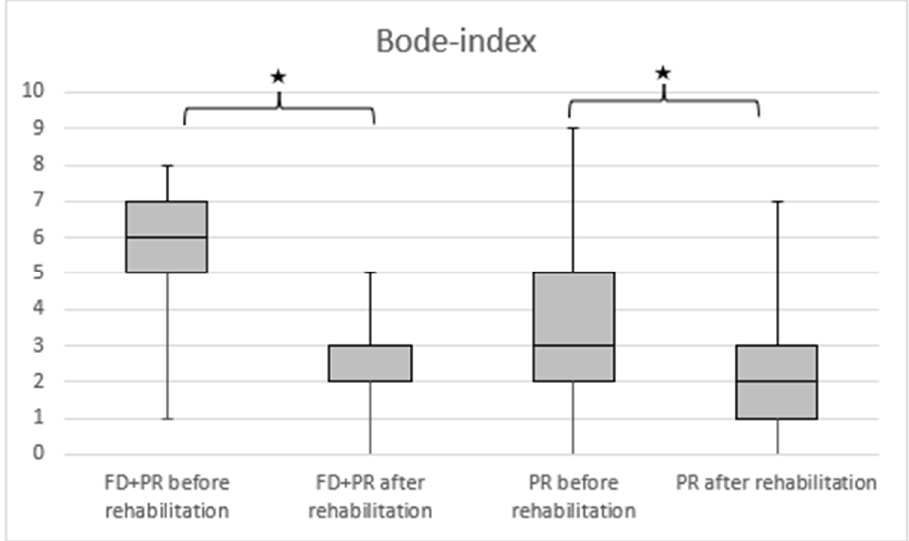
Figure 3. The change in the severity of COPD (measured by BODE index) in the PR and PR + FD groups. BODE index: FEV 1 , 6MWD, BMI, and mMRC; PR: pulmonary rehabilitation; FD: freediving training; * p < 0.001 after vs. before rehabilitation.